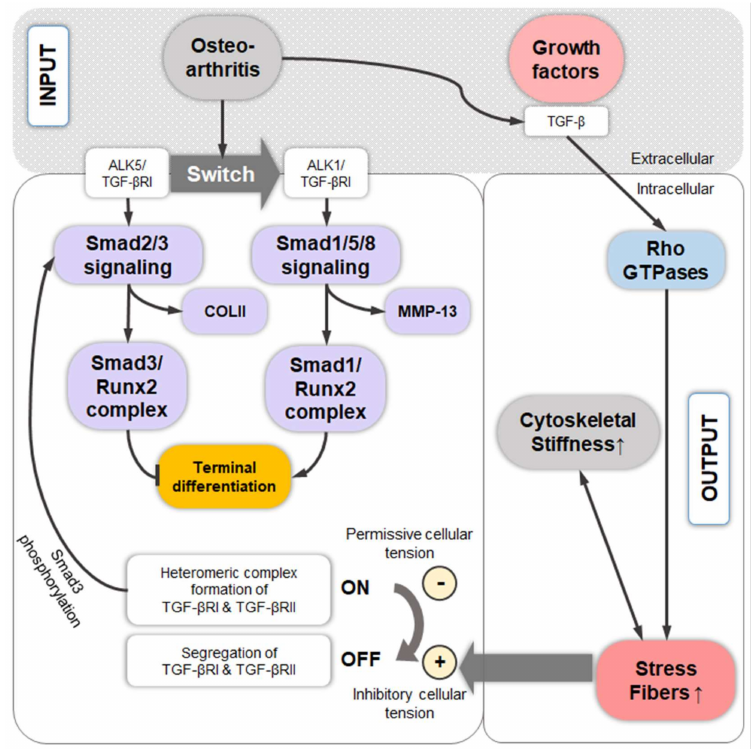
Figure 8. The TGF- β -induced stress fiber formation, cell stiffening, and OA-induced switch of the TGF- β receptors and downstream Smad signaling, causing terminal differentiation. During OA onset, increased TGF- β induces stress fiber formation through Rho GTPase signaling. Segregation of TGF- β RI and TGF- β RII through inhibitory cellular tension inhibits Smad3 phosphorylation, whereas a heteromeric complex formation of TGF- β RI and TGF- β RII through permissive cellular tension is required for Smad3 phosphorylation. Additionally, the receptor switches from ALK5/TGF- β RI and downstream Smad2/3 signaling, mediating COL2 production, to ALK1/TGF- β RI and downstream Smad1/5/8 signaling, mediating MMP-13 expression. Complex formation of Smad3 with Runx2 inhibits terminal differentiation, whereas the Smad1–Runx2 complex induces terminal differentiation in CHs. Abbreviations: COLII: type II collagen, MMP-13: matrix metalloproteinase 13, TGF- β : transforming growth factor β , TGF- β RI: transforming growth factor β receptor I, TGF- β RII: transforming growth factor β receptor II. The up arrow indicates an